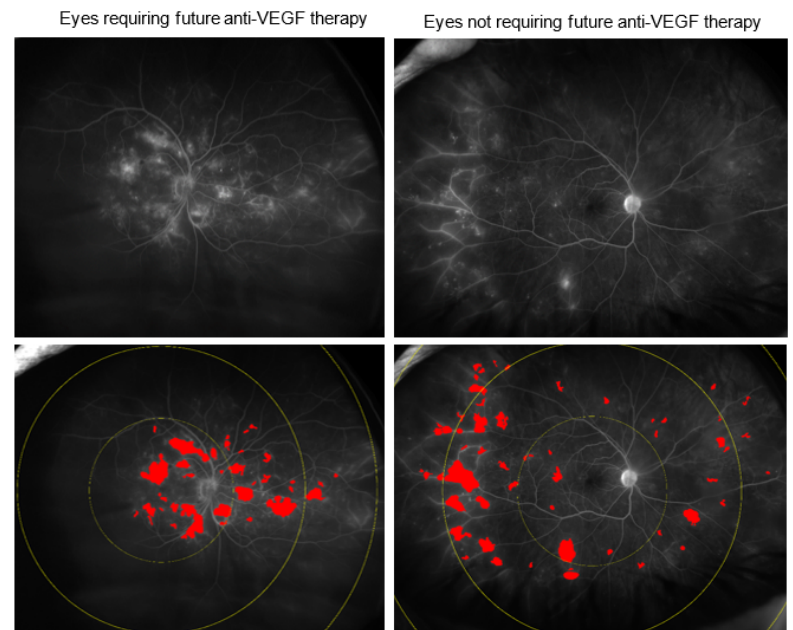
Figure 2. Leakage index in eyes requiring future anti-VEGF therapy. Total leakage index and posterior pole leakage index on UWFA were significantly higher in eyes requiring future anti-VEGF therapy compared to eyes not requiring future injections.